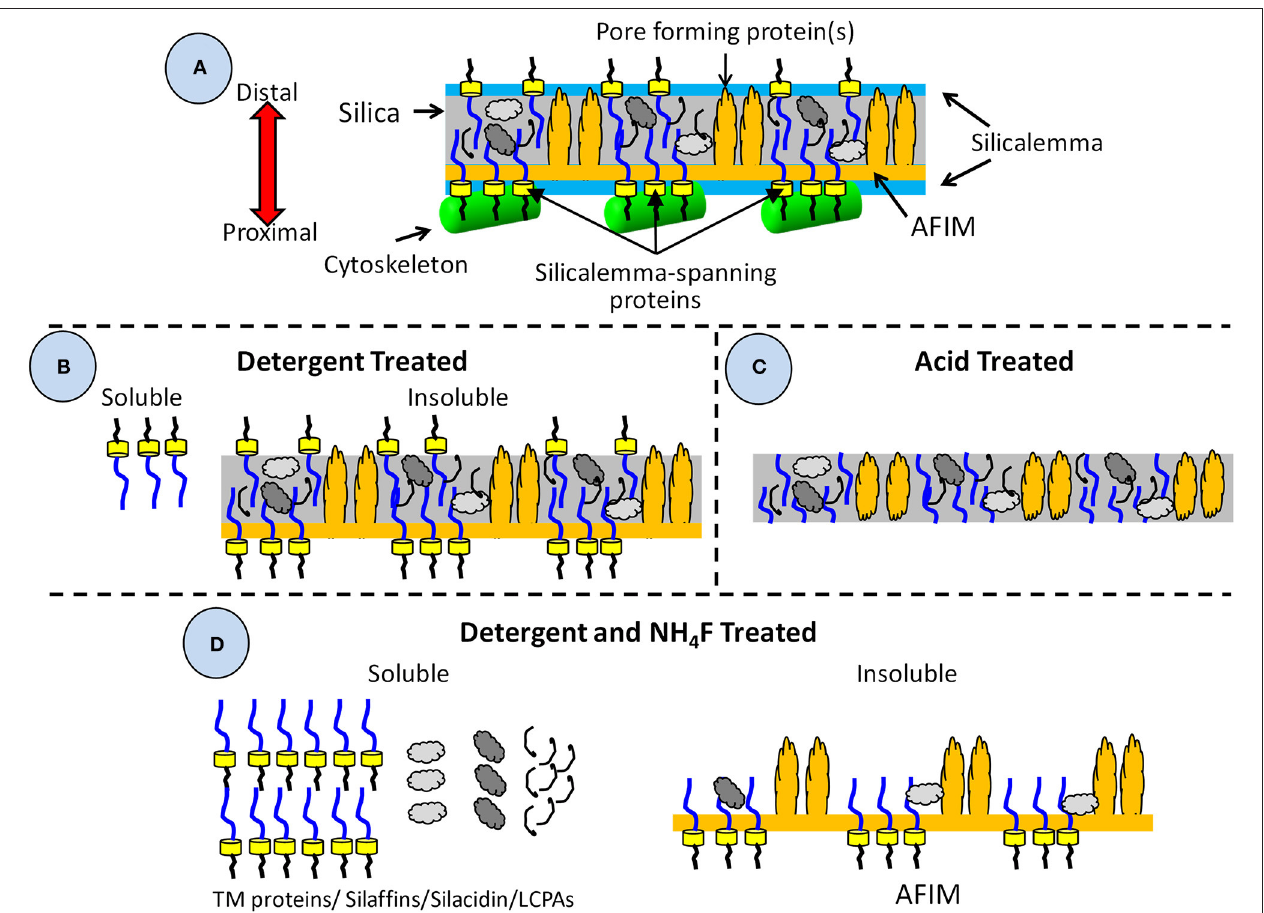
FIGURE 4 | Diagram of valve and associated components detailing their solubility in different detergents and isolation treatments. (A) All components associated with the valve during its formation including those embedded in the silica, or associated with the AFIM or silicalemma, including the cytoskeleton. (B) Components resulting from detergent extraction, which removes the cytoskeleton, silicalemma, and proteins associated with the silicalemma that are not embedded in the silica, leaving a soluble and insoluble fraction. (C) Components resulting from acid treatment, which removes all organic material external to the silica. It is assumed that embedded material is at least partially protected from acid degradation. (D) Components resulting from detergent extraction and dissolution of the silica by ammonium fluoride, resulting in a soluble fraction of silica-embedded and silicalemma components, and an insoluble fraction of the AFIM and any proteins that had become associated via crosslinking to